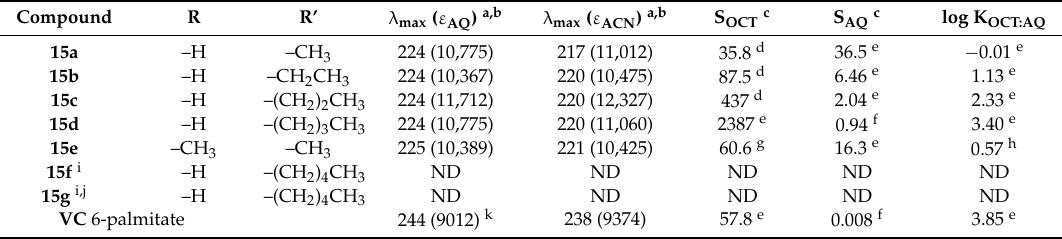
Table 1. Molar extinction coefficients in water ( ε AQ ) or in acetonitrile ( ε ACN ), solubilities in water (S AQ ) and in 1-octanol (S OCT ) and log partition coefficients between 1-octanol and water (logK OCT:AQ ) for L -ascorbic acid